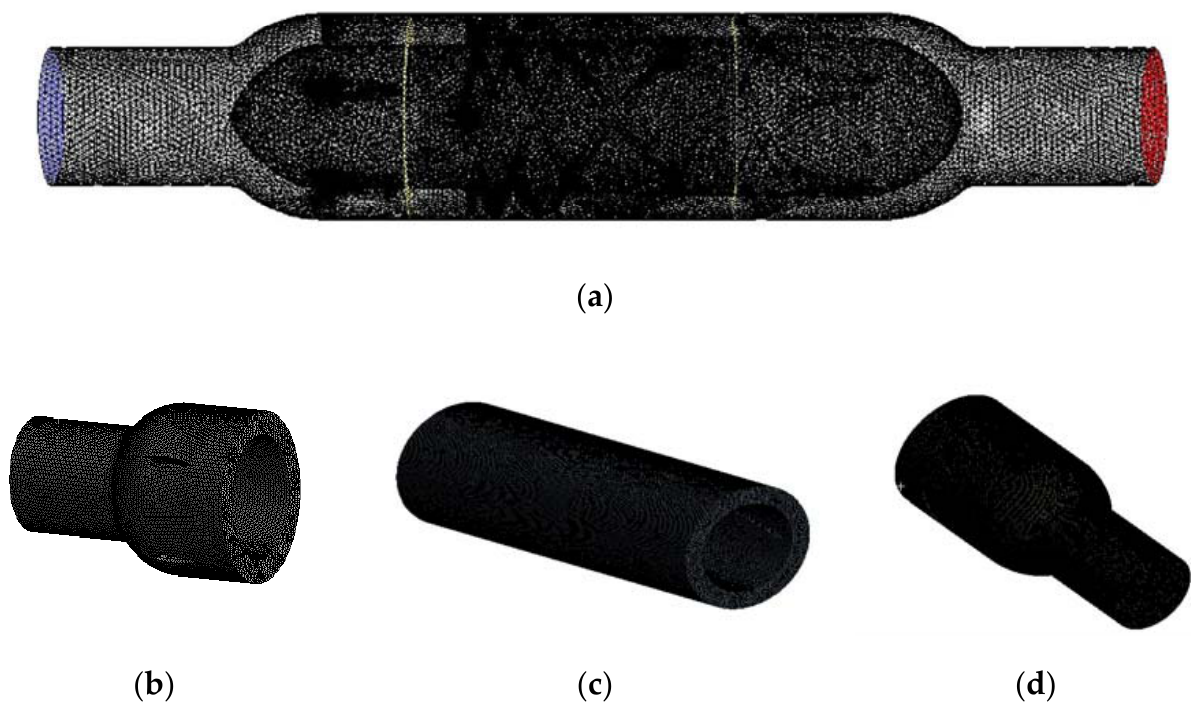
Figure 4. Flow channel meshing model. ( a ) Whole flow channel, ( b ) front guide wheel section, ( c ) impeller section, and ( d ) rear guide wheel section.